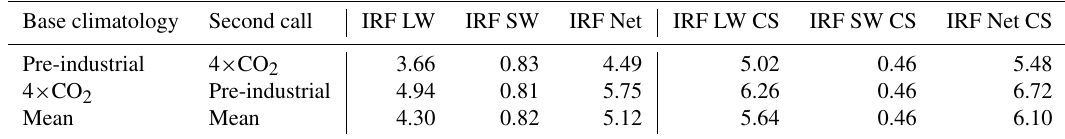
Table 2. IPSL-CM6A-LR double-call results for 4 × CO 2 experiments. IRFs are given in watts per square metre (Wm − 2 ). Base climatology Second call